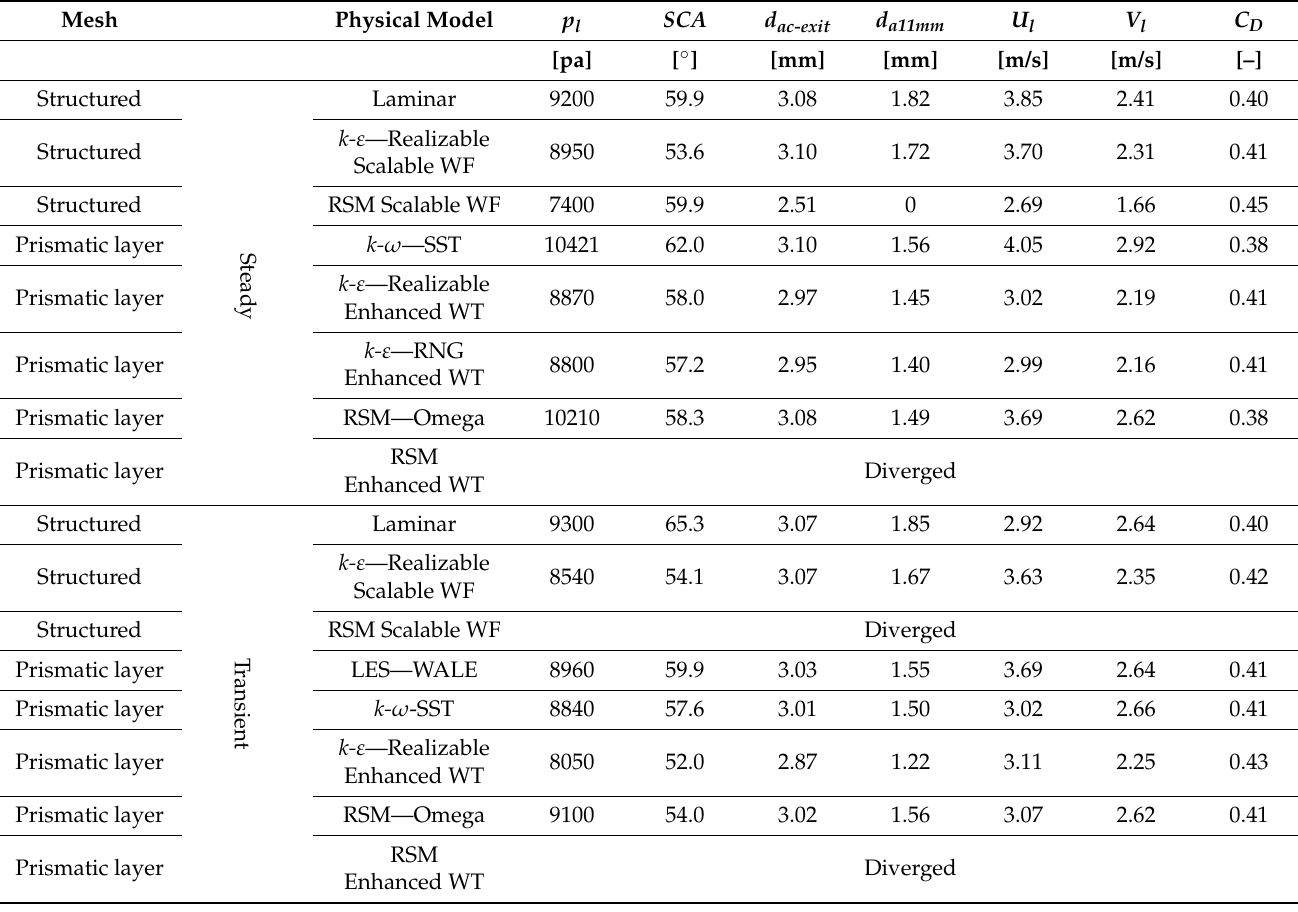
Table 4. Comparison of different physical models, 3D periodic mesh with port, Re =